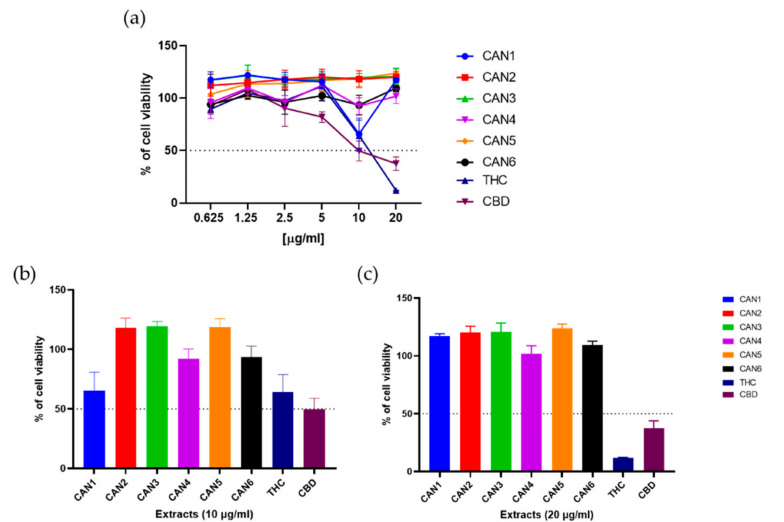
Figure 5. Responsiveness of HUIEC cells to different Cannabis sativa extracts, THC and CBD. ( a ) Cells were treated with different concentrations (0.625–20 µ g/mL) of the extracts for 48 h, and cell viability was determined by MTT assay. Sections ( b , c ) show the concentrations of 10 µ g/mL and 20 µ g/mL, respectively. Data show cell viability relative to untreated controls (mean + S.D. from n = 4 replicate